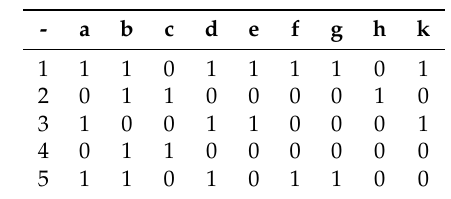
Table 1. A formal